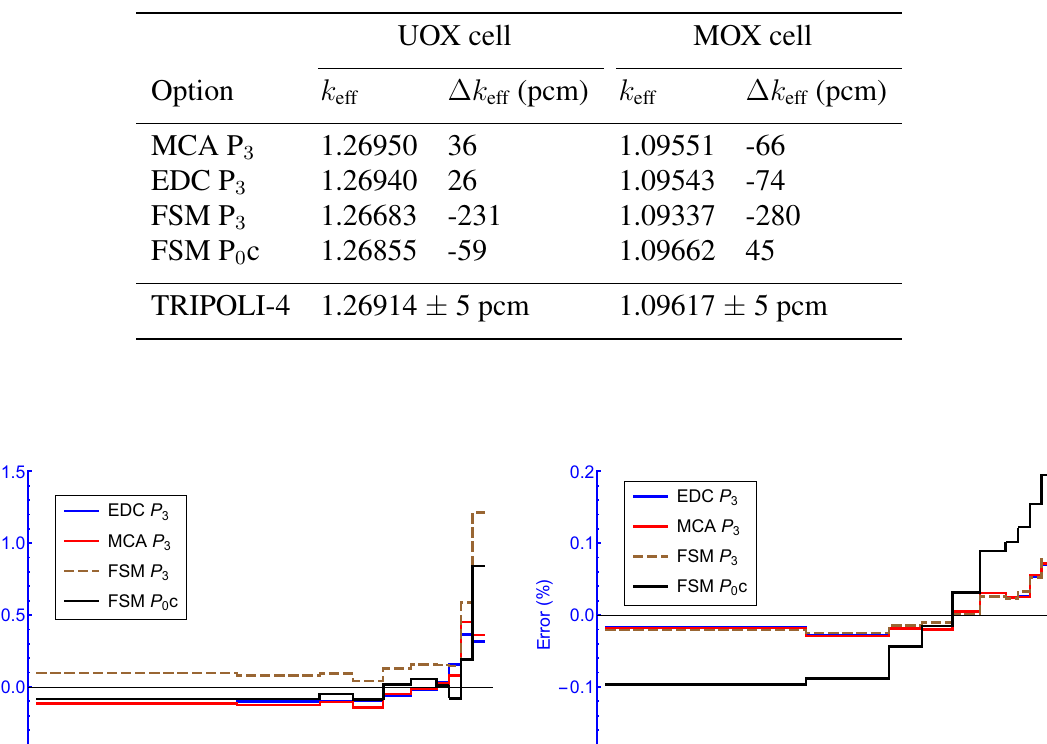
discrepancies eff